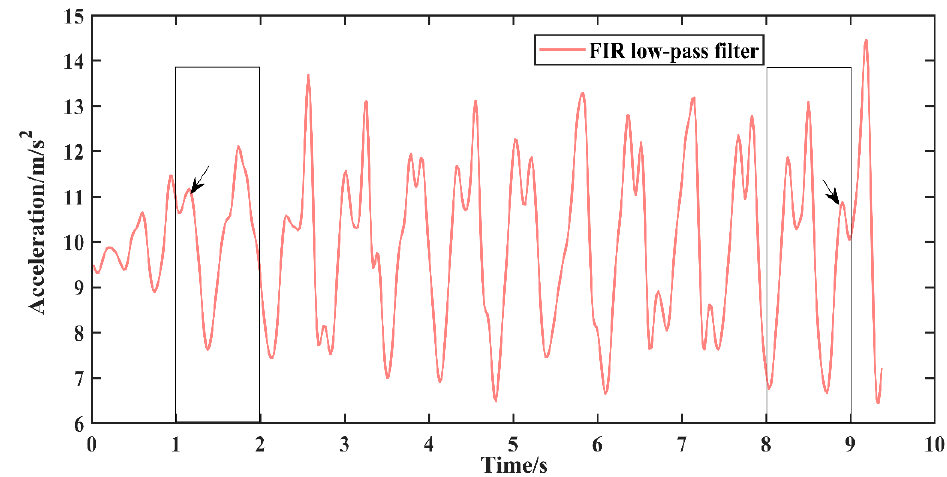
Figure 8. Pseudo ‐ peaks in front of the window and at the end of the window. Figure 8. Pseudo-peaks in front of the window and at the end of the window.